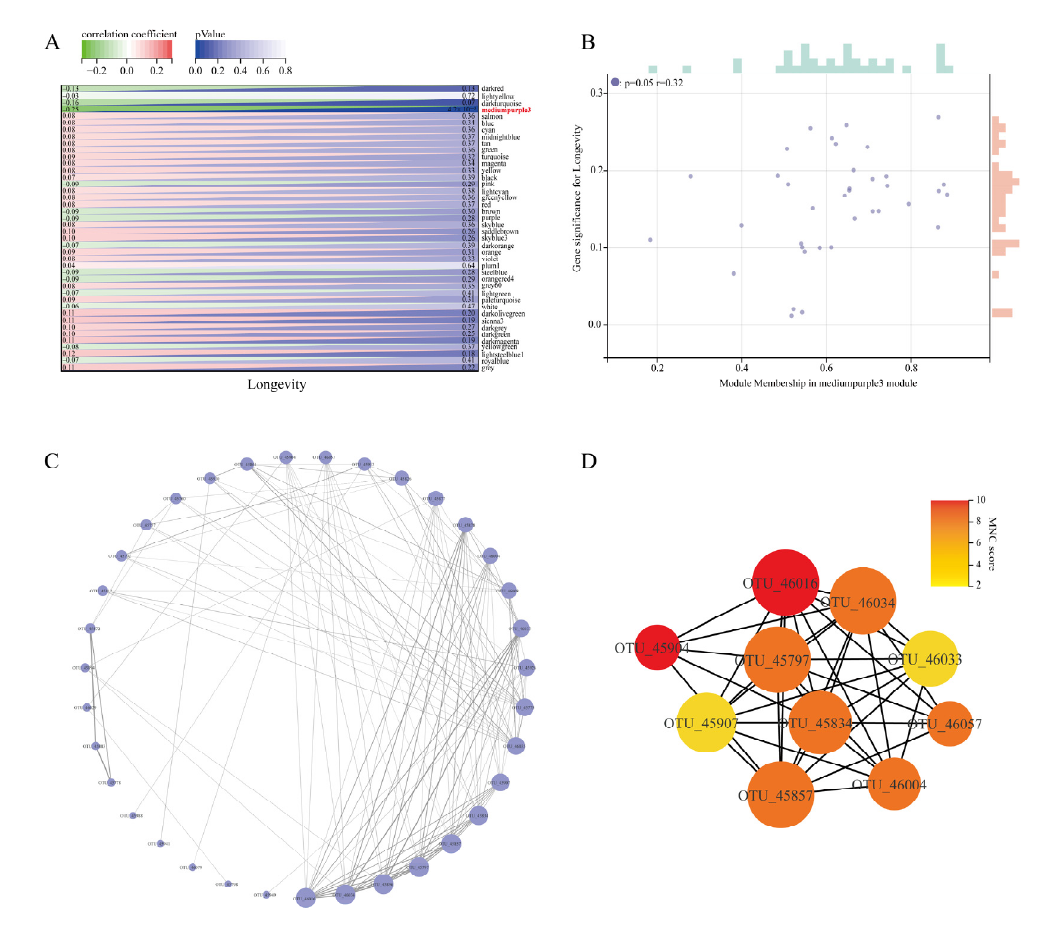
Figure 3. Identification of core network modules associated with longevity and visualisation. ( A ) Heatmap of trait correlations between modules. Each row corresponds to a trait module, and each column corresponds to a trait. The numbers on the left of the cells represent the correlation coefficient r-values, and the numbers on the right represent the p -values corresponding to each module. ( B ) Correlation between module membership (MM) and gene significance (GS) in the longevity key module is indicated. The GS scatter plot of longevity traits versus MM in the mediumpurple3 module is shown here. The size of the rectangle above and to the right of the image indicates the relative size of the number of genes at the same level. A larger rectangle indicates a larger relative size of the number of genes contained at that level. ( C ) Circular layout of the microecological co-expression network of the mediumpurple3 module. The size of the circles in the plot represents connectivity, and the darker colour of the connecting lines indicates higher weights. ( D ) Identification of core OTUs in the microecological co-expression network of the mediumpurple3 module using cytoHubba plugin. The size of the circles represents connectivity, and a darker node colour indicates a higher score for the maximum neighbour component (MNC), i.e., better centrality in the network module.